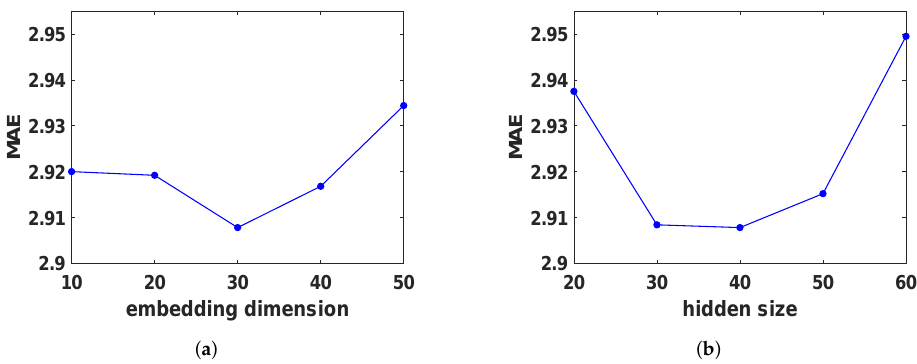
Figure 6. Parameters study on METR-LA. ( a ) Performance with different embedding dimensions. ( b ) Performance with different hidden sizes.